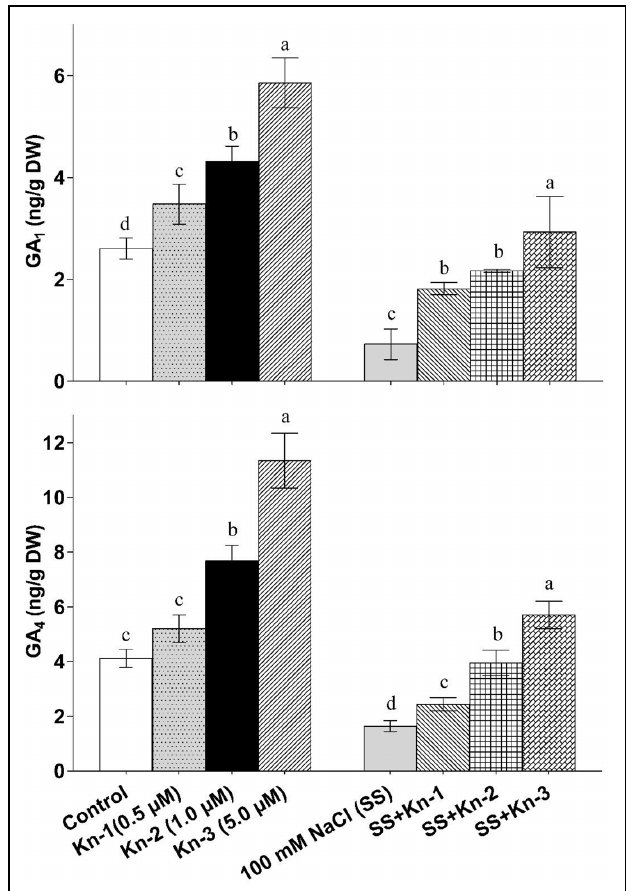
FIGURE 5 | Effect of exogenous application of Kinetin (Kn) and NaCl on the endogenous bioactive Gibberellins (GAs) including GA 1 and GA 4 contents of soybean shoots. Seedlings of soybean were exposed to different concentrations of Kn and NaCl after 17 days of sowing (17 DAS) and harvested after 24 h. Graph represents data from nine replicates in two independent experiments (data are mean ± SD; n = 18). Bars labeled with different letters shows significant difference ( p < 0.05; Duncan test).